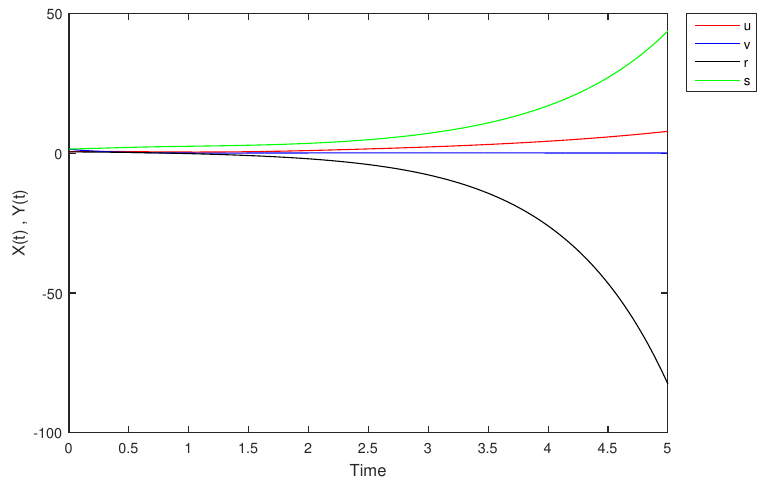
Figure 7. The solution of (6) at α = 0.